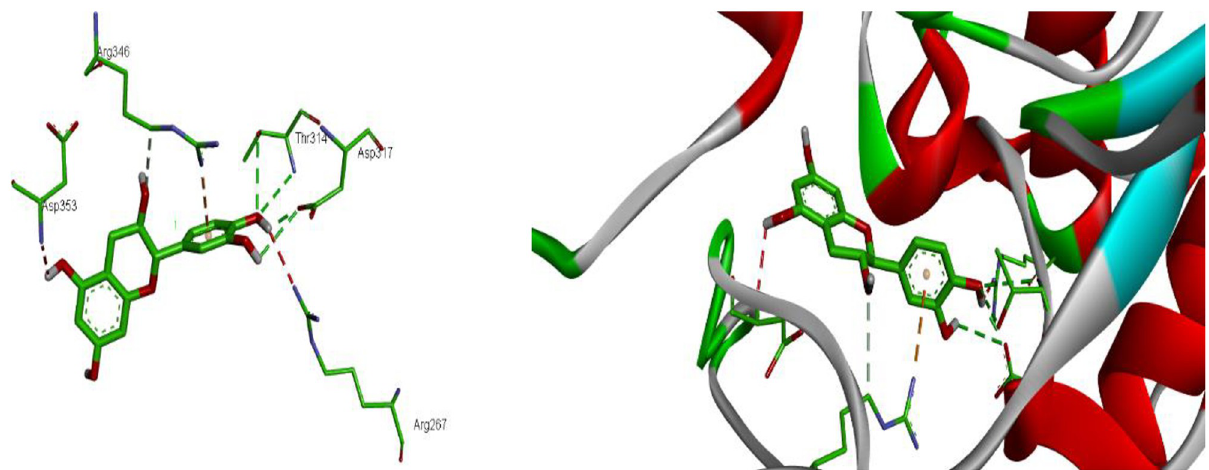
Fig 7. 2D and 3D representation of the interaction of catechin with human pancreatic alpha-amylase (PDB ID: 2QV4). https://doi.org/10.6084/ m9.figshare.21828909.v1.